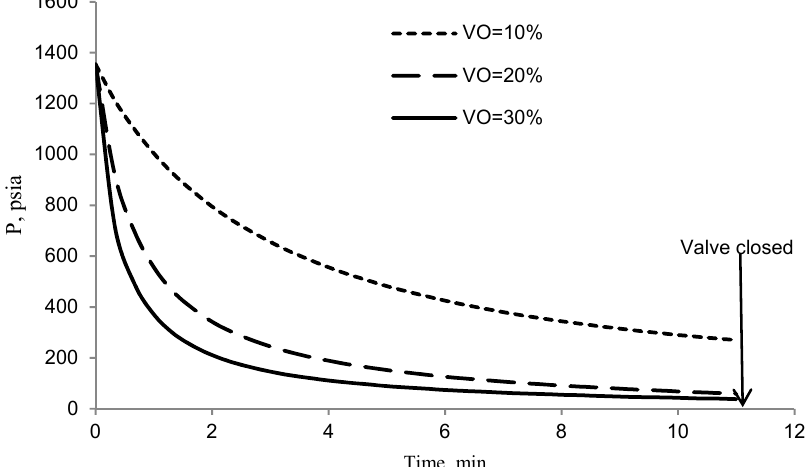
Figure 10. Valve opening controls the bleed down time.